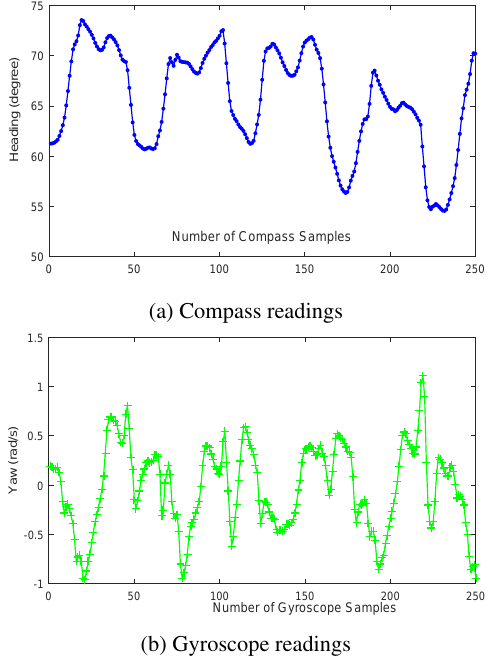
(b) Gyroscope readings Figure 6: The changes in the compass and gyroscope readings when the user walks along a straight path with the phone in the hand (without swinging) The DR method suffers from the accumulated error problem, which is illustrated in figure 7. In figure 7, the black line represents a part of the ground-truth path that the user walks on. The blue line with the dot marker is the corresponding result of DR using the compass to provide the heading, while the green line with the plus marker is that using the gyroscope reading for calculating the heading where the initial heading value is given by the compass. From this figure, we can see that the error of DR increases sig- nificantly with time, which means that landmarks or other spatial information are needed to bound the localization accuracy.